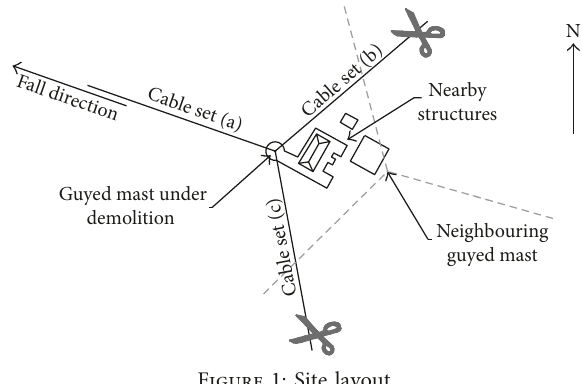
Guyed mast under demolition at t =0s Neighbouring mast